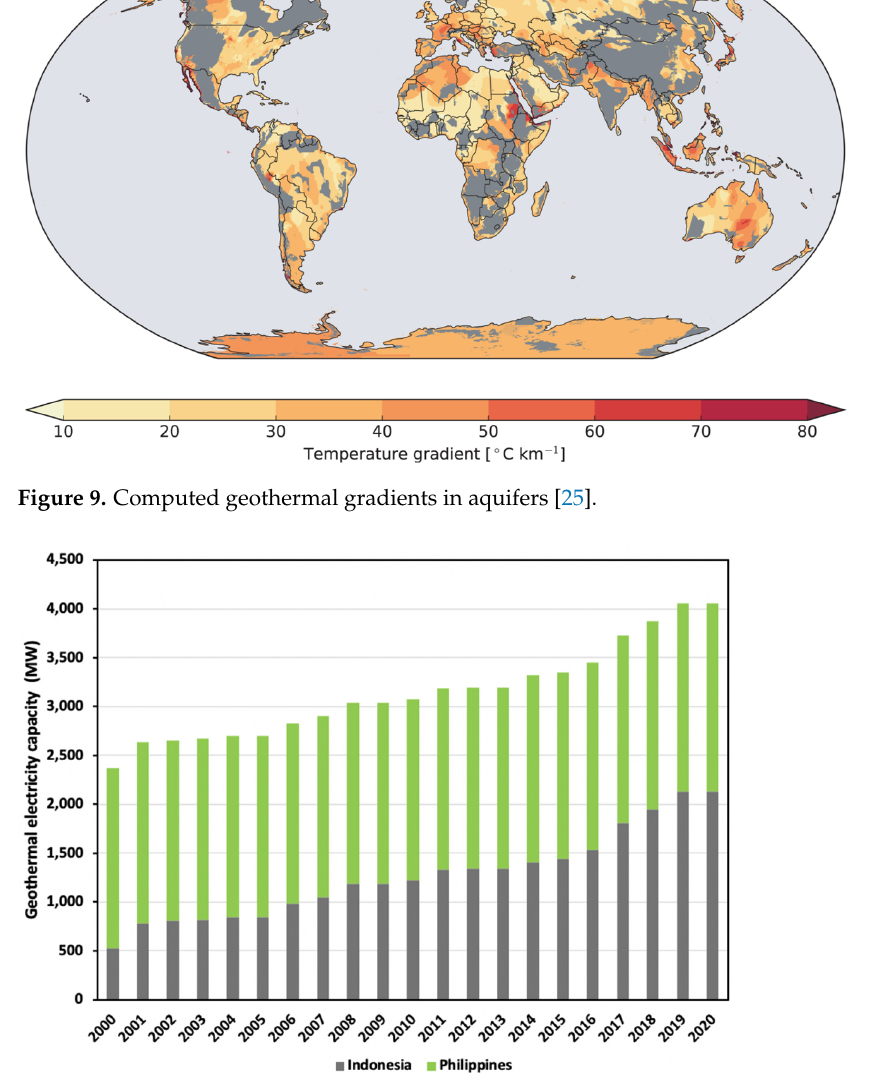
Figure 10 . History of installed geothermal capacity in ASEAN [22] .